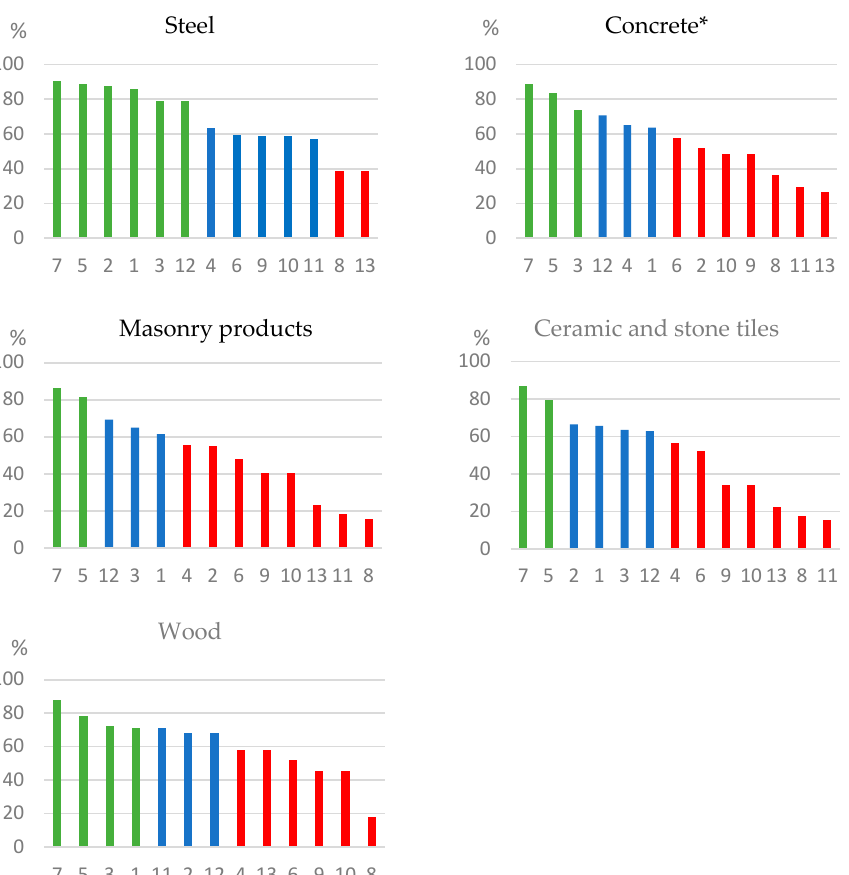
Figure 5. The distribution of the frequency of application of individual methods of waste reduction in relation to the studied groups of products (* including a concrete mix and prefabricated concrete elements).